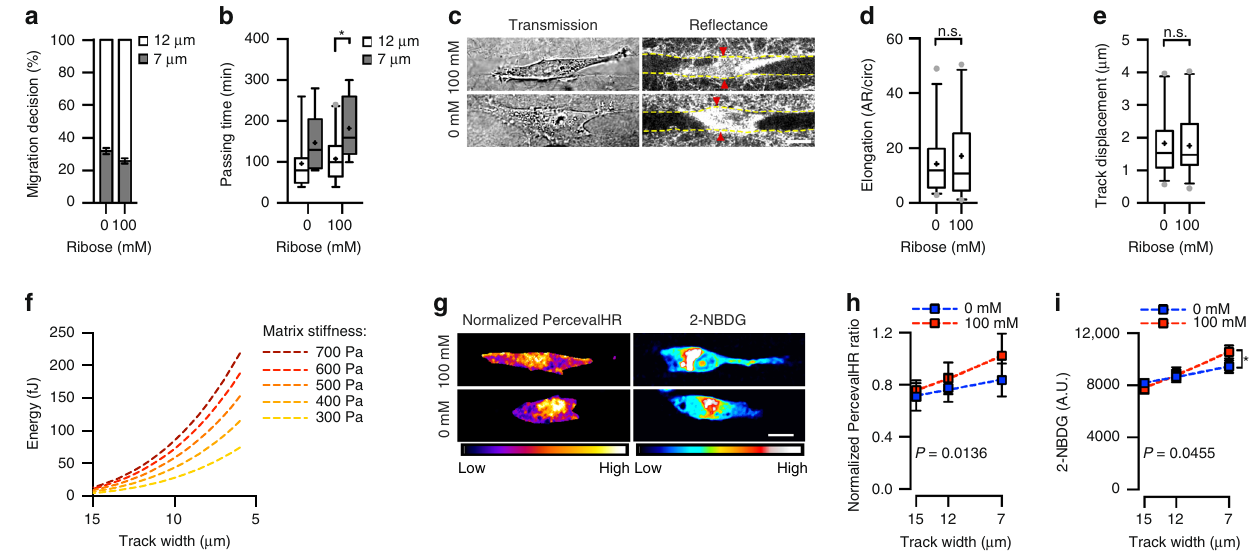
Fig. 5 Matrix stiffness in fl uences decision-making, cellular ATP:ADP ratio, and glucose uptake during con fi ned migration. a , b Migration decision-making ( a ) and passing time into each branch ( b ) in 0 mM and 100 mM glycated collagen microtracks ( n = 25, 27 cells for 0 mM, 100 mM). c Transmitted light images showing cell morphology and confocal re fl ectance images of microtrack structure as well as cell-induced track displacement in 7 μ m microtracks (yellow lines show microtrack walls; red arrowheads show areas of matrix displacement around the cell body). d , e Quanti fi cation of cell elongation ( d ) and track displacement ( e ) for cells in the 7 μ m track of 0 mM and 100 mM glycated collagen gels ( n = 31, 29 cells for 0 mM, 100 mM). f Model predictions for energy requirements for migration into tracks of varying size with increasing cell stiffness. g Normalized PercevalHR heatmap and 2-NBDG heatmap of cells in matrices of varying stiffness following glycation. h , i Normalized PercevalHR ratio ( n = 0 mM: 47, 30, 31; 100 mM: 49, 28, 29 cells for 15, 12, 7 μ m tracks) ( h ) and 2-NBDG uptake ( n = 0 mM: 96, 53, 59; 100 mM: 71, 46, 35 cells for 15, 12, 7 μ m tracks) ( i ) with increasing con fi nement in collagen gels glycated with 0 mM or 100 mM ribose. Data shown as mean ± s.e.m. ( a , h , i ), or median ± interquartile range (box), 5th – 95th percentiles (whiskers), and mean ( + ) ( b , d , e ); dashed lines show exponential fi t; two-tailed Mann – Whitney test ( b , d , e , h , i ) and extra sum-of-squares F-test for comparing curves ( h , i ); * P < 0.05, n.s. = not signi fi cant. Scale bar, 15 μ